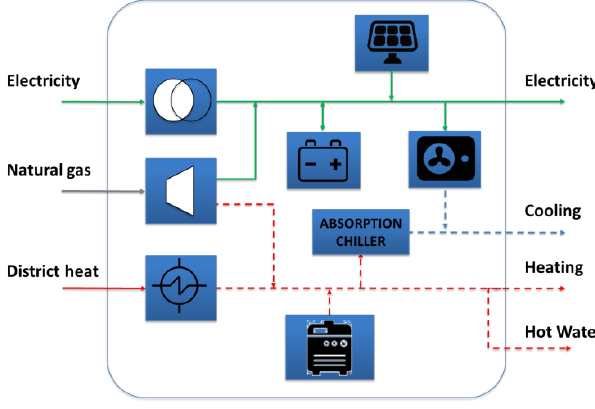
Figure 1. An energy hub containing typical elements.